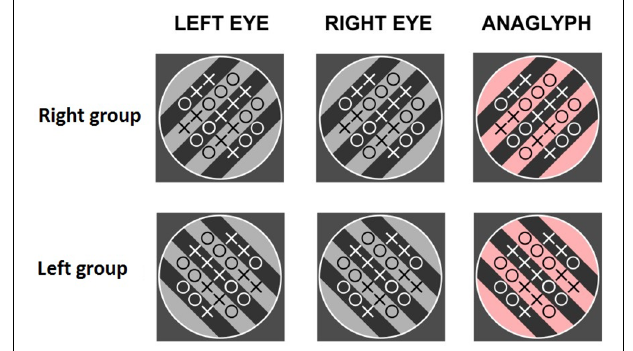
FIGURE 5 | Experiment 2. Examples of the counting task. Different subjects saw right-, left-oriented gratings or both types of gratings, on different trials (control